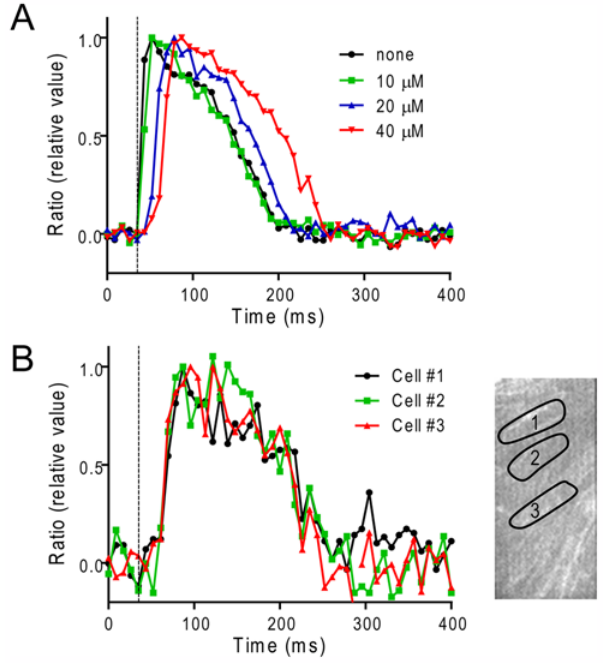
Figure 5. Effect of Na + channel blocker on action potential signals in ventricular muscles. A healthy muscle was stimulated at 1 Hz by a pair of field electrodes placed at the end of the muscle, , 2 mm distant from the field of view. A. Overlay of action potential signals from the whole field of view in the absence and presence of pilsicainide (0 , 40 m M). B. Overlay of action potential signals in individual cells in the presence of 40 m M pilsicainide (cell 1 , 3).